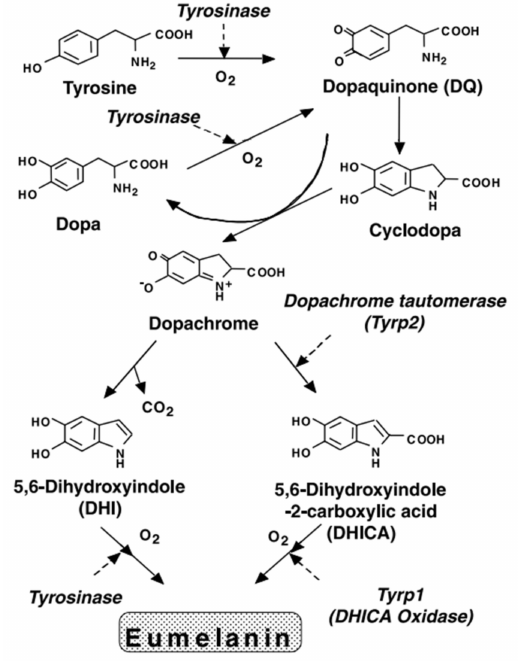
Figure 3. The Rapor–Mason scheme for melanogenesis. Adapted with permission from [35]; © 2003 John Wiley & Sons, Inc. (Hoboken, NJ, USA).